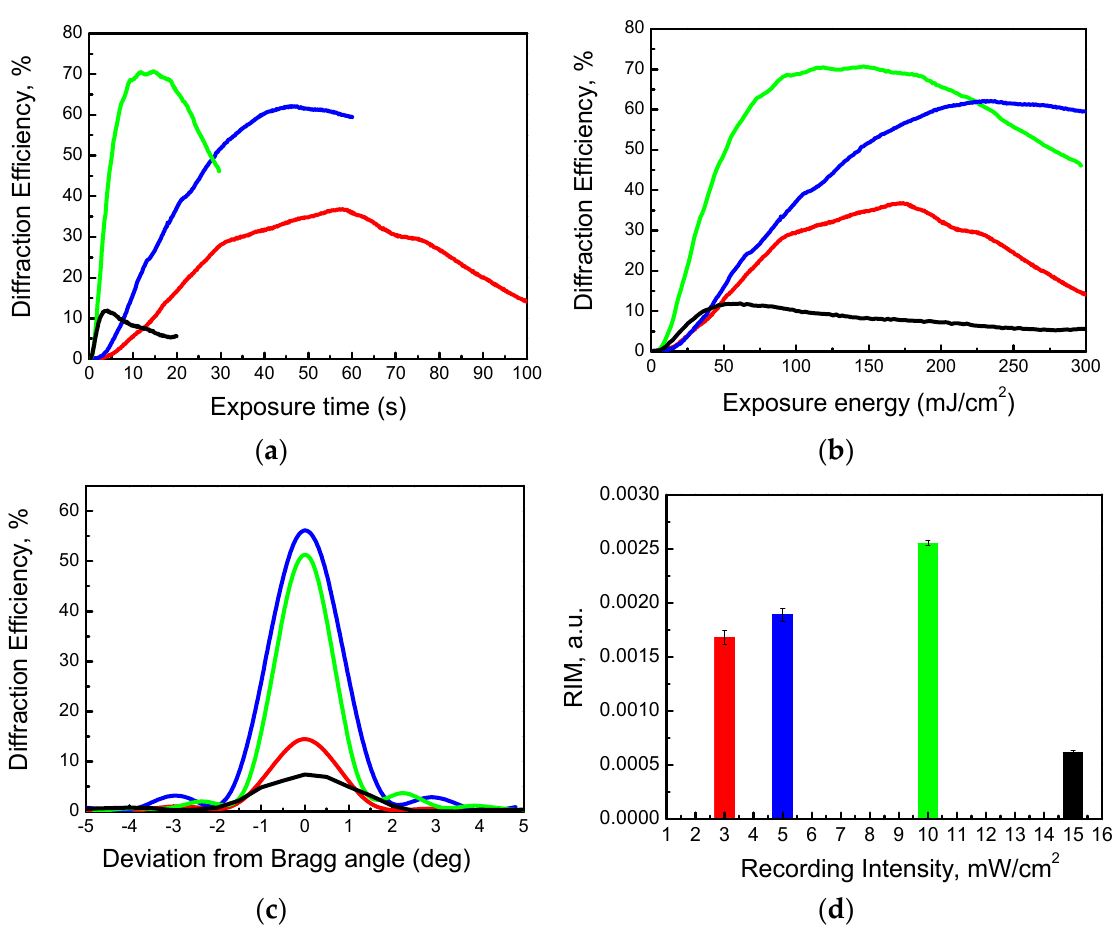
Figure 9. Recording of grating with spatial frequency of 800 linepairs/mm with total intensity of 3 mW/cm 2 (red), 5 mW/cm 2 (blue), 10 mW/cm 2 (green) and 15 mW/cm 2 (black). ( a ) Diffraction efficiency of the grating versus exposure time; ( b ) diffraction efficiency versus exposure energy; ( c ) Bragg selectivity curves for the gratings; ( d ) maximum achieved refractive index modulation. Experiments are performed in triplicate.